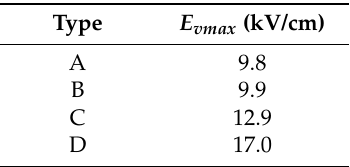
Table 4. Sliding flashover of all four bushing samples.